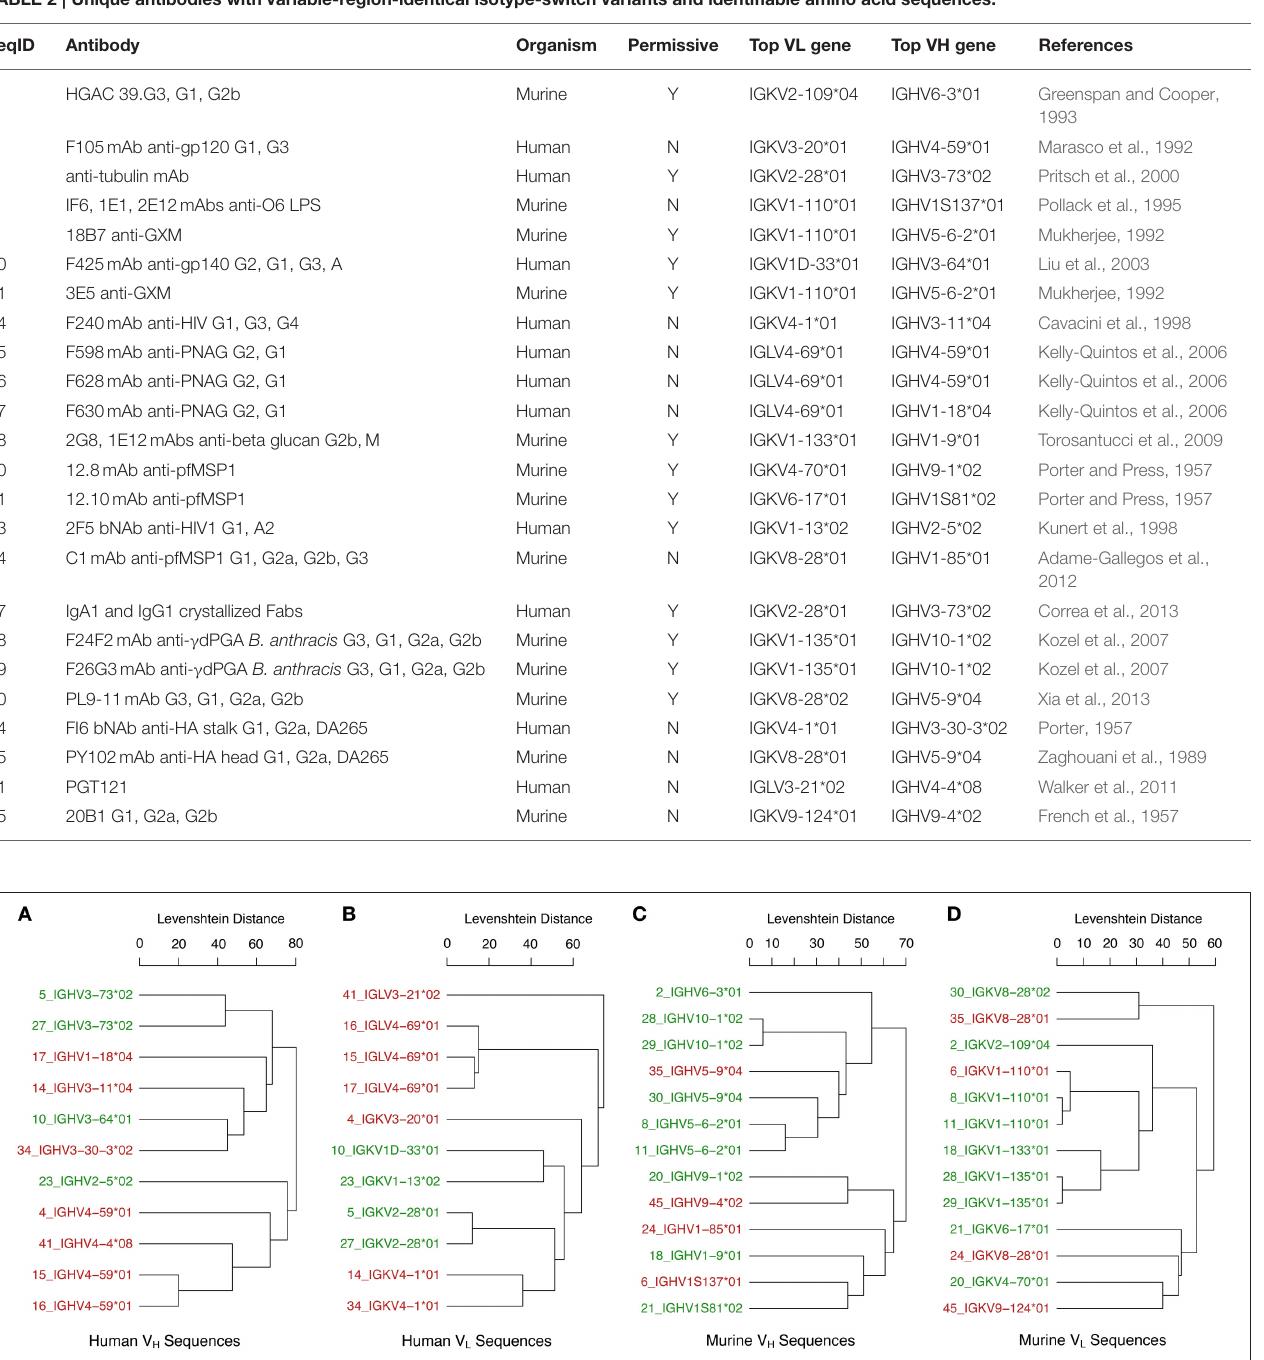
Frontiers in Microbiology |